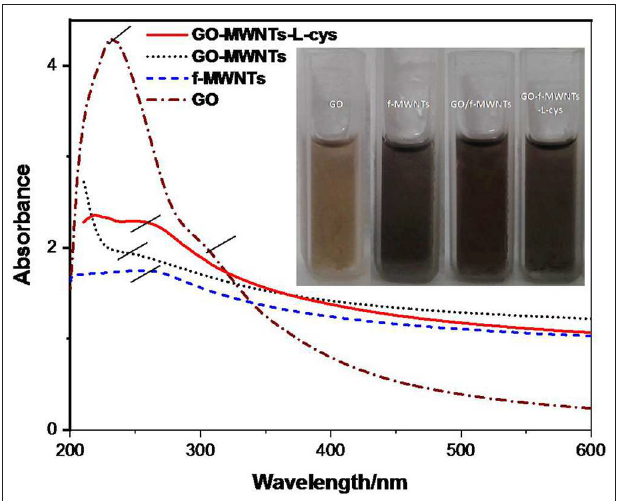
FIGURE 2 | UV-vis spectra of GO, MWNTs, GO–MWNTs, and GO–MWNTs–L-cys. Inset represents the digital photo of these samples.